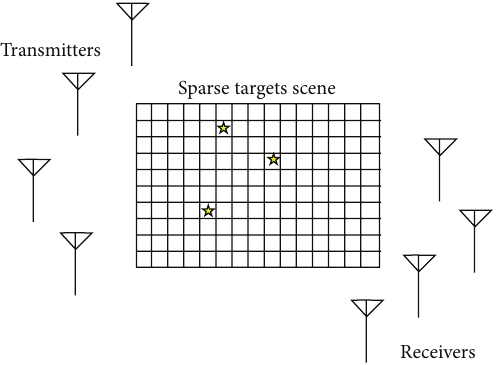
Figure 1: Sparse targets scene of DCS-MIMO